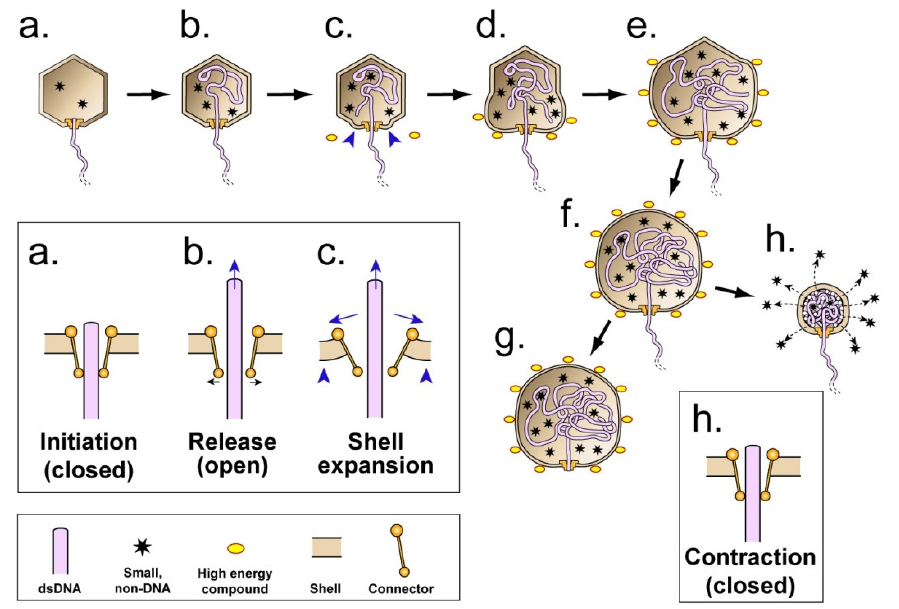
Figure 5. A proposed, pre-classical DNA packaging motor that has only connector and outer shell proteins. The legend at the bottom indicates the representation of DNA molecule, high-energy compound, packaged non-DNA molecule and capsid proteins. The insets (enclosed by rectangles) show the connector region of the corresponding capsid at higher